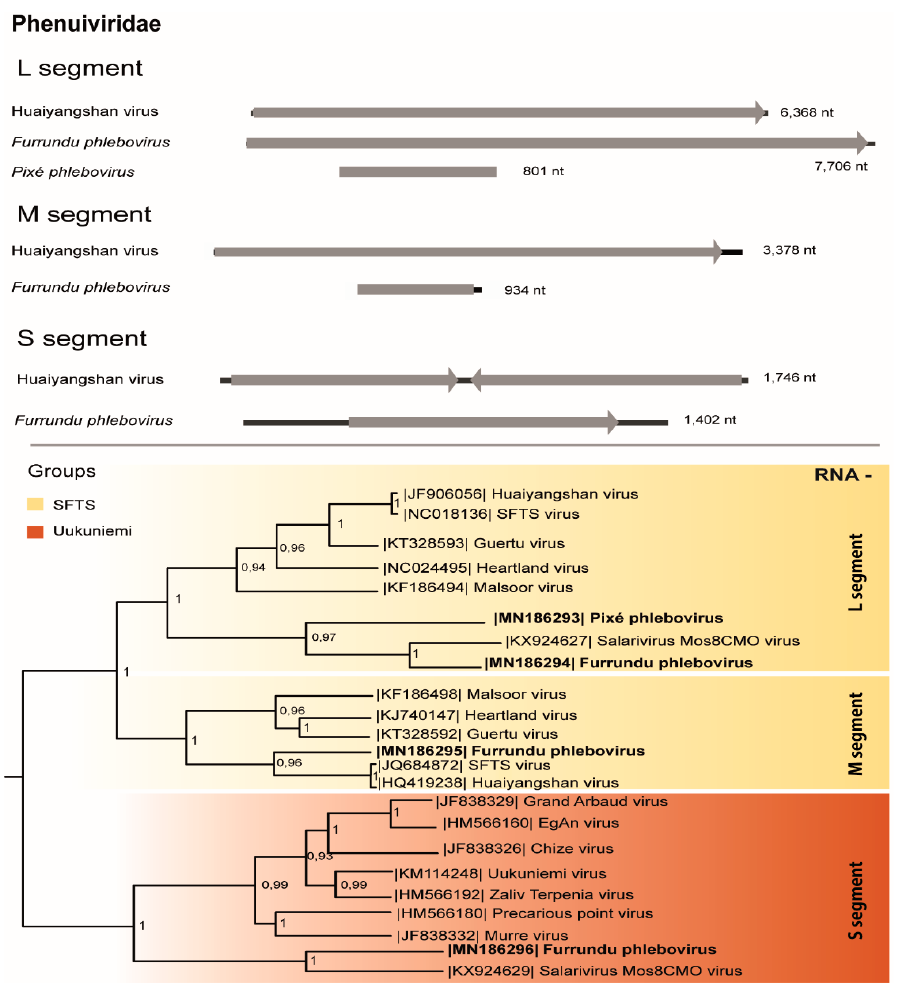
Figure 3. Genome map and phylogenetic tree of Furrundu phlebovirus and Pixé phlebovirus RNA dependent RNA polymerase (L), structural polyprotein (M), and nucleoprotein (S) by the maximum likelihood method and other Phenuiviridae members.